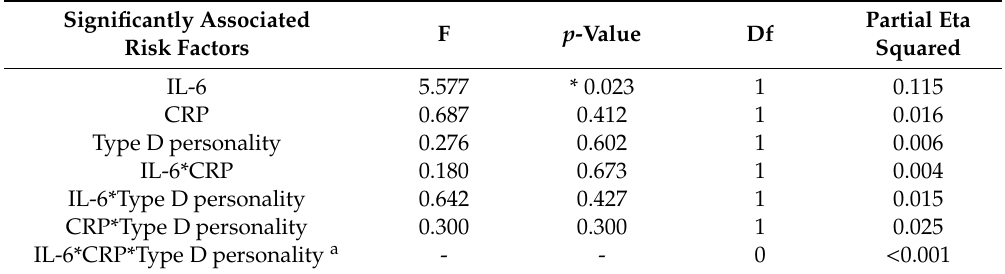
Table 3. E ff ect size of peripheral pro-inflammatory markers and type D personality on the baseline depressive